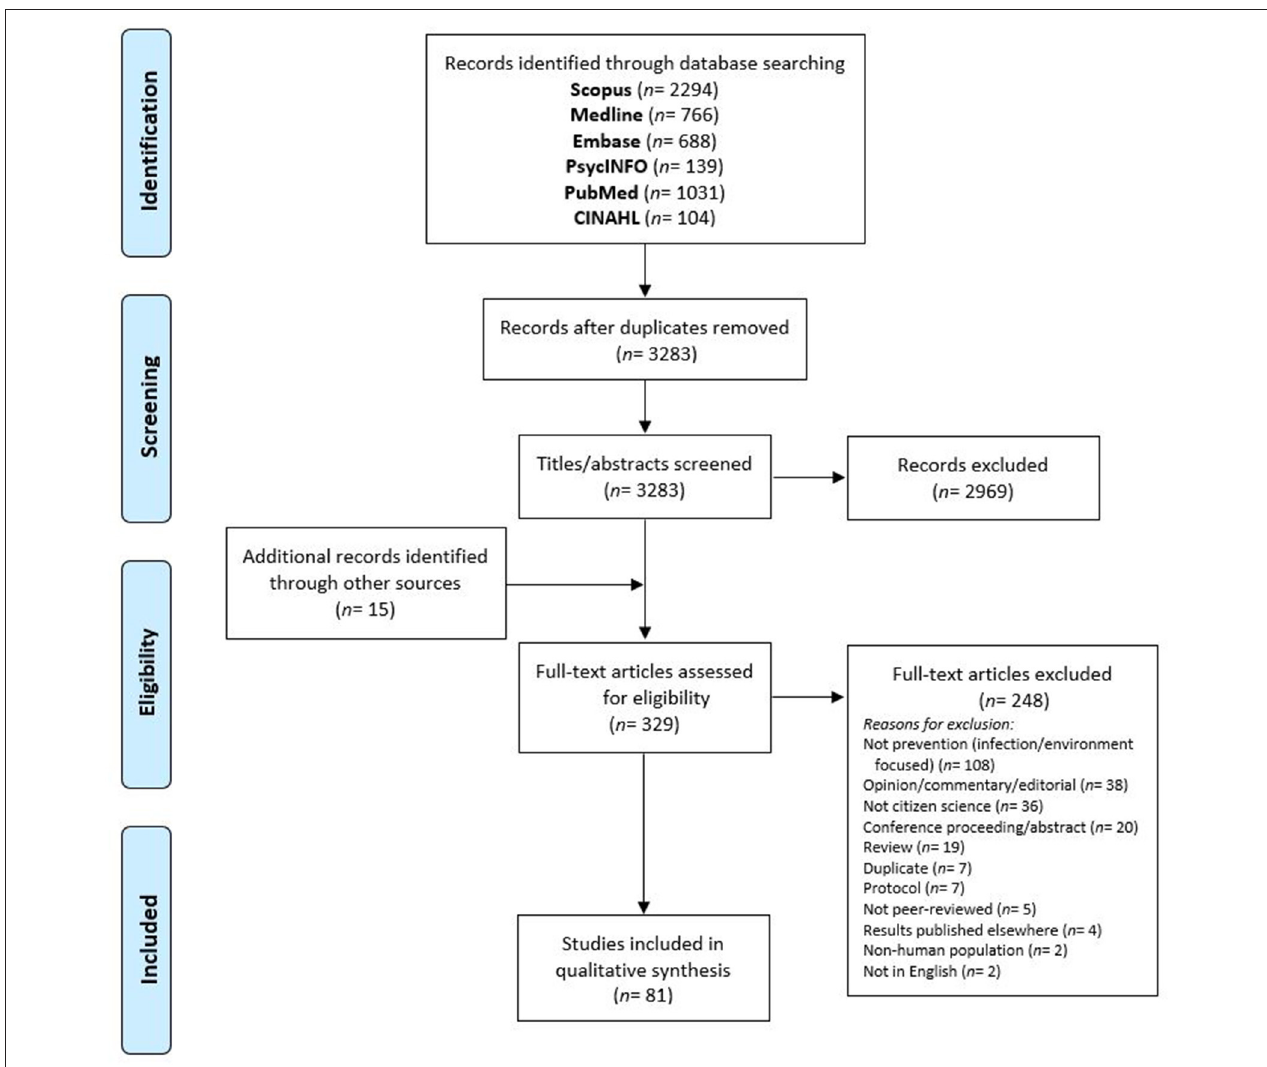
FIGURE 3 | PRISMA flow